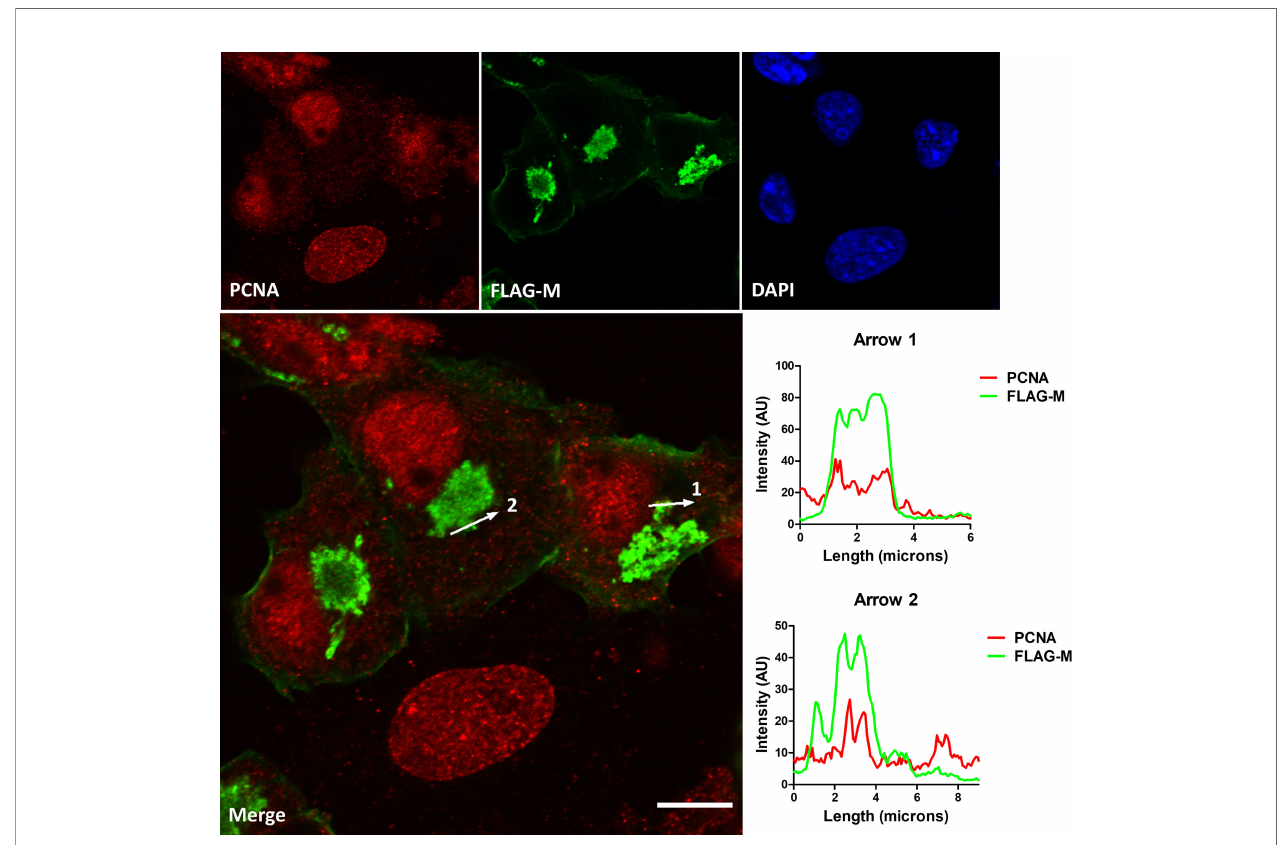
FIGURE 3 | Co-localization of FLAG-M and PCNA by confocal immuno fl uorescence. Vero E6 cells expressing FLAG-M and stained for PCNA (red) and FLAG-M (green) were analyzed by confocal microscopy. The plot pro fi le of two arrowed areas (arrows 1 and 2) indicates an overlap in signals of both proteins, as shown in the graphs on the right. Images were taken at 100× magni fi cation with a Zeiss LSM-780-NLO microscope. Scale bar 10 m